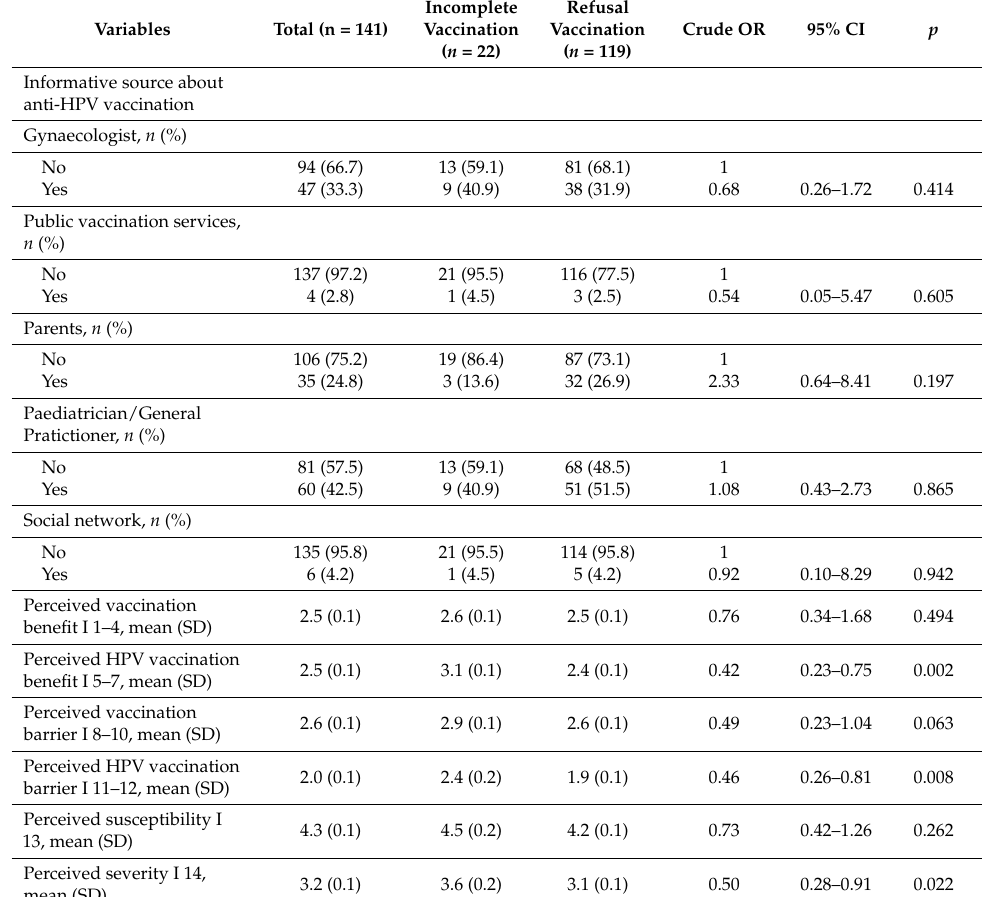
Table 2. HPV vaccination knowledge and HBM (Health Belief Model) questions of young adult